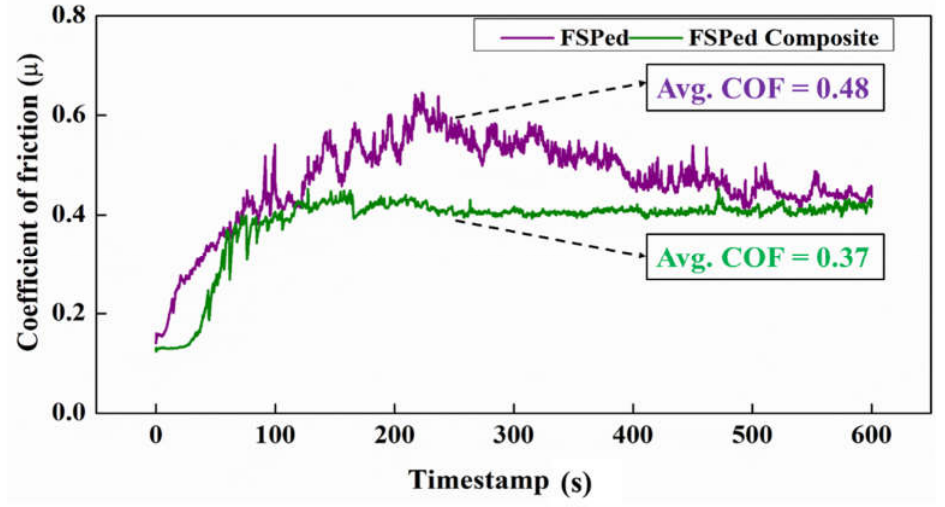
Figure 11. Generation of COF with sliding time for FSPed and Al359/Si 3 N 4 /Eggshell surface compo-